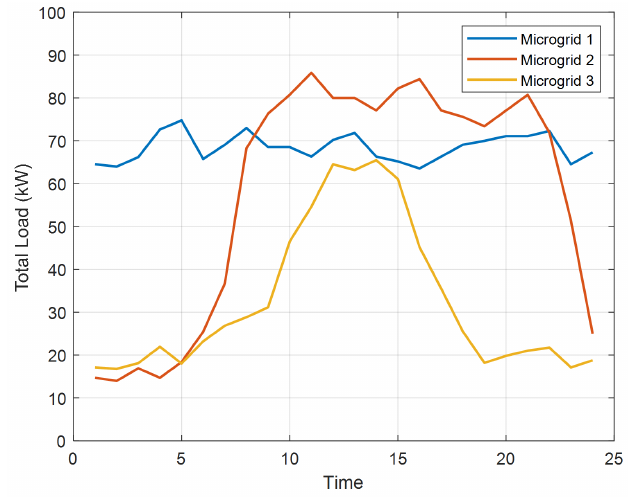
Figure 4. Load of each